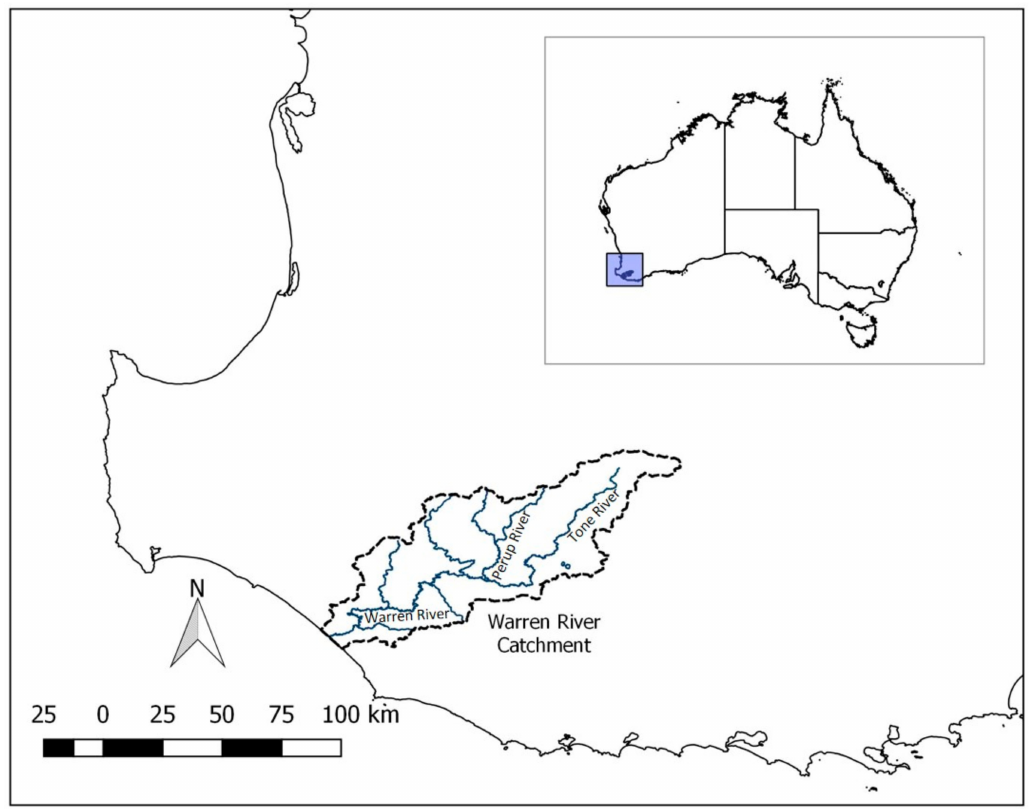
Figure 1. Location of the Warren River and its tributaries in south-western